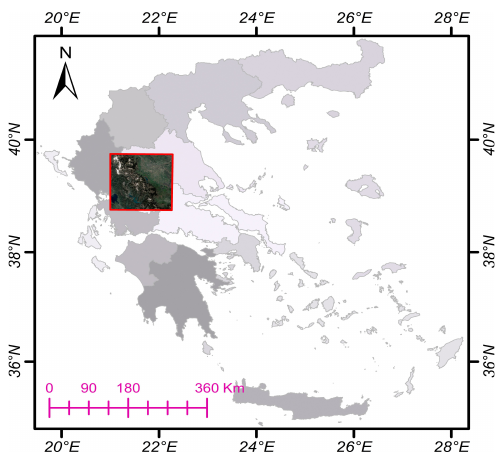
Figure 1. The study area (in red box) corresponding to the Sentinel-2 tile 34SEJ (in a natural color composite of March 2016) and its location on the Greek